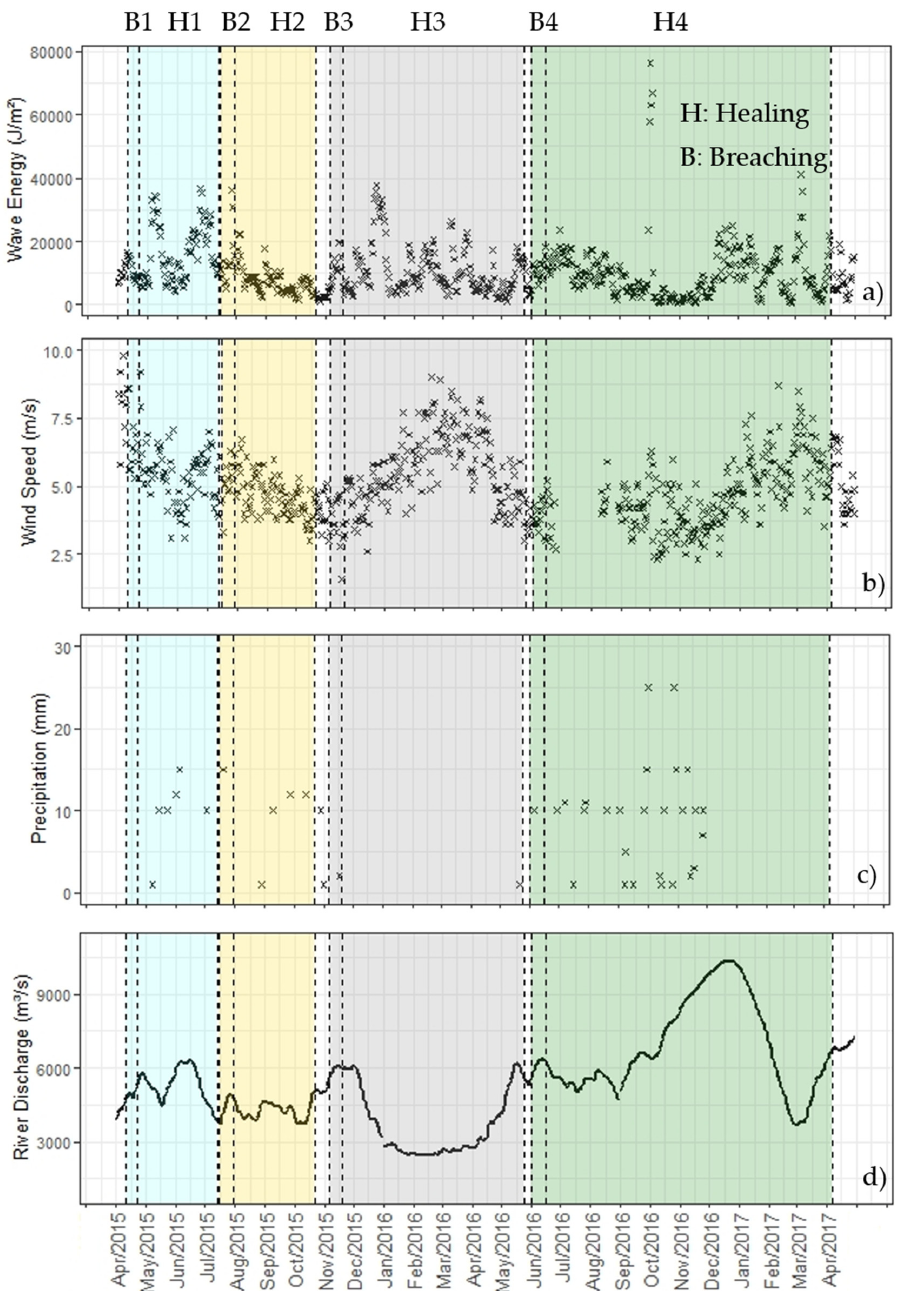
Figure 13. Color-coded daily maximum of potential drivers of lagoon healing and breaching in Cuatro Bocas between April 2015 and April 2017. Panels indicate maximum daily values for ( a ) wave energy, ( b ) wind speed, ( c ) precipitation, and ( d ) the Magdalena River discharge. Vertical dashed lines indicate the ranges of breachings and healings.